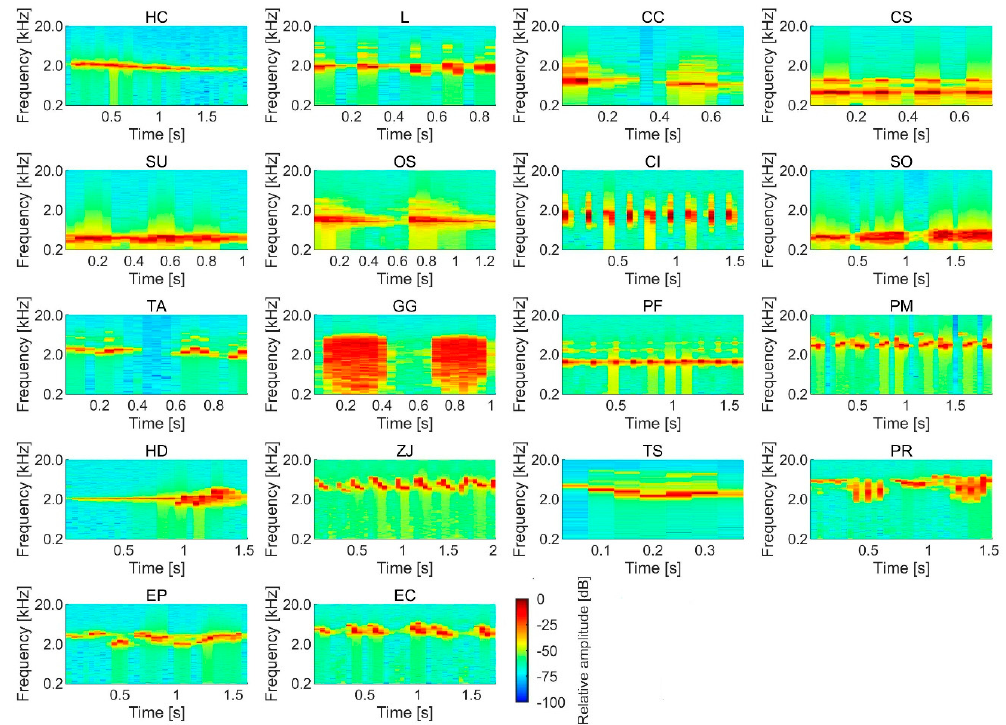
Figure 2. Spectrograms of the 18 birdsong stimuli used.